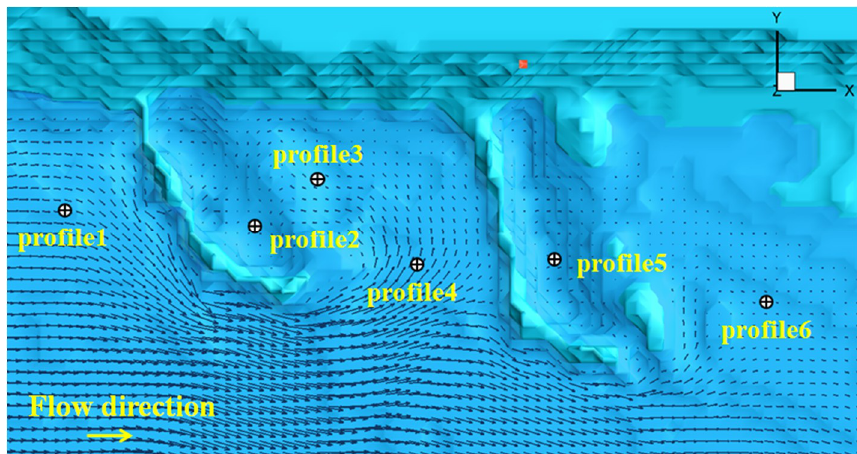
Figure 9. Locations of the selected velocity profiles.